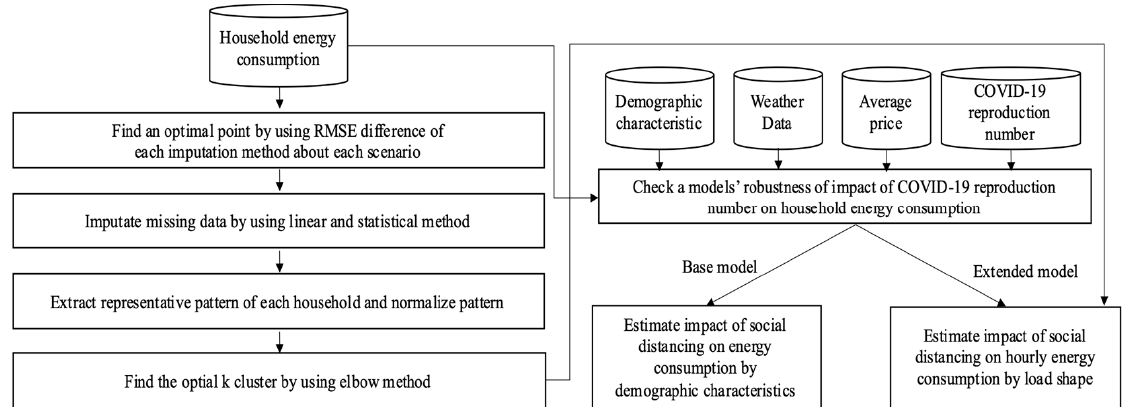
Figure 1. Flowchart of the proposed procedure for analyzing the impact of social distancing on household energy consumption.